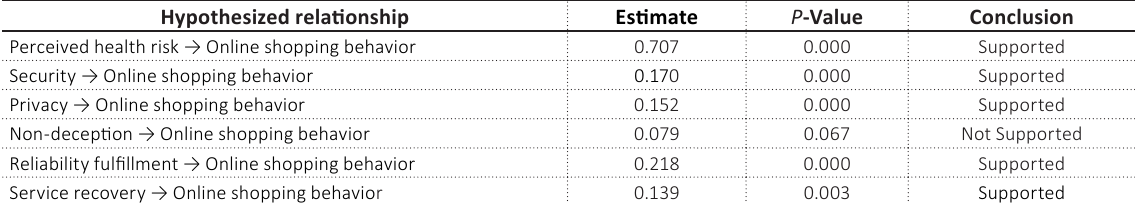
Table 3. Structural parameter